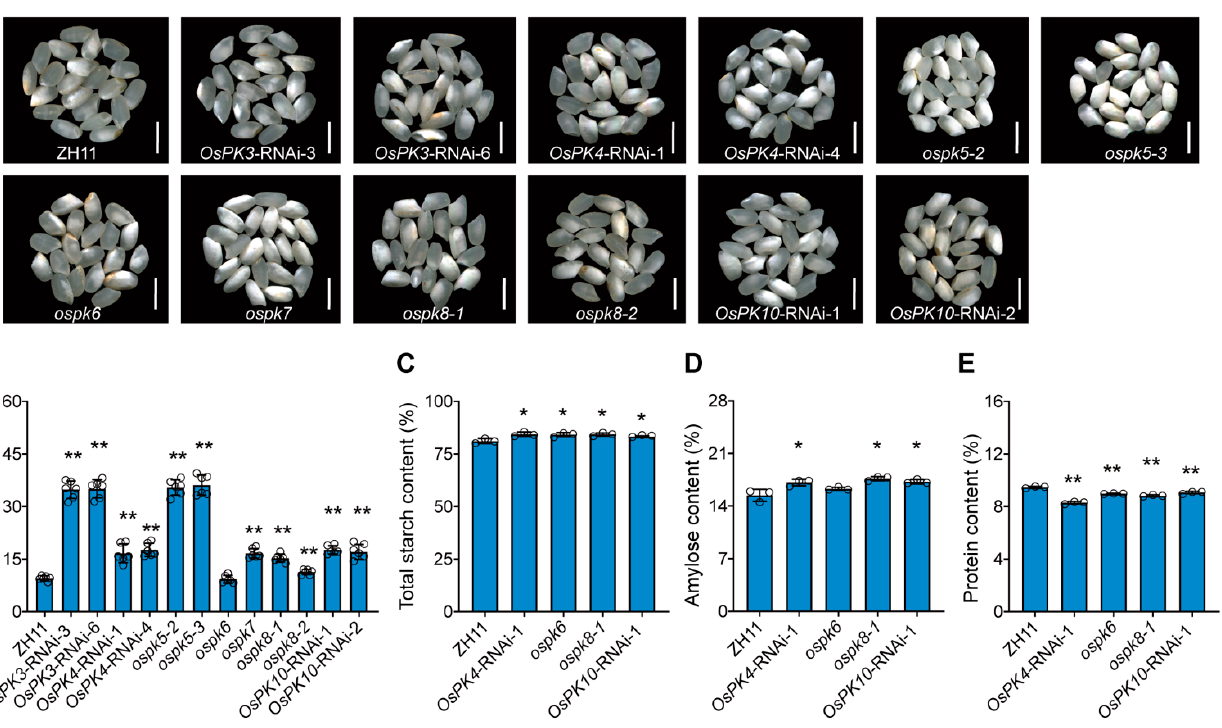
Figure 8. Grain quality of ZH11, CRISPR/Cas9-based mutants, and RNAi-based material with respect to PK genes in rice. ( A ) Phenotypes of seeds of ZH11, OsPK3 -RNAi-3, OsPK3 -RNAi-6, OsPK4 -RNAi-1, OsPK4 -RNAi-4, ospk5-2 , ospk5-3 , ospk6 , ospk7 , ospk8-1 , ospk8-2 , OsPK10 -RNAi-1, and OsPK10 -RNAi-2. Scale bars = 5 mm. ( B ) Chalkiness rate of the WT, mutant, and RNAi material seeds. Error bars indicate the means ± SDs of six biological replicates. ( C – E ) Total starch contents, amylose contents, and protein contents of WT, mutant, and RNAi line seeds. Error bars indicate the means ± SDs of three individual replicates. Asterisks indicate statistical significance between the WT and the mutants and RNAi material seeds, as determined by Student’s t -test (* p < 0.05; ** p < 0.01).